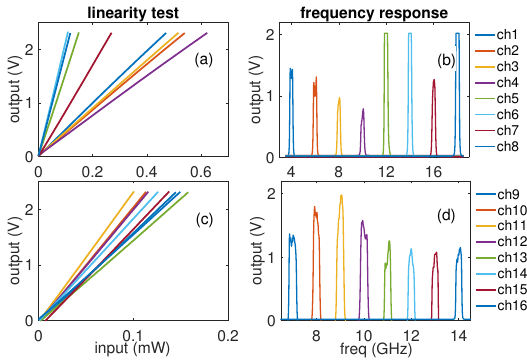
Figure 4. Tests of IF linearity ((a) and (c)) and frequency re- sponse ((b) and (d)) for the new 16 channels. The IF central frequency of the top is from 4 to 18 GHz, with 2 GHz separation, while the bottom is from 7 to 14 GHz, with 1 GHz separation.